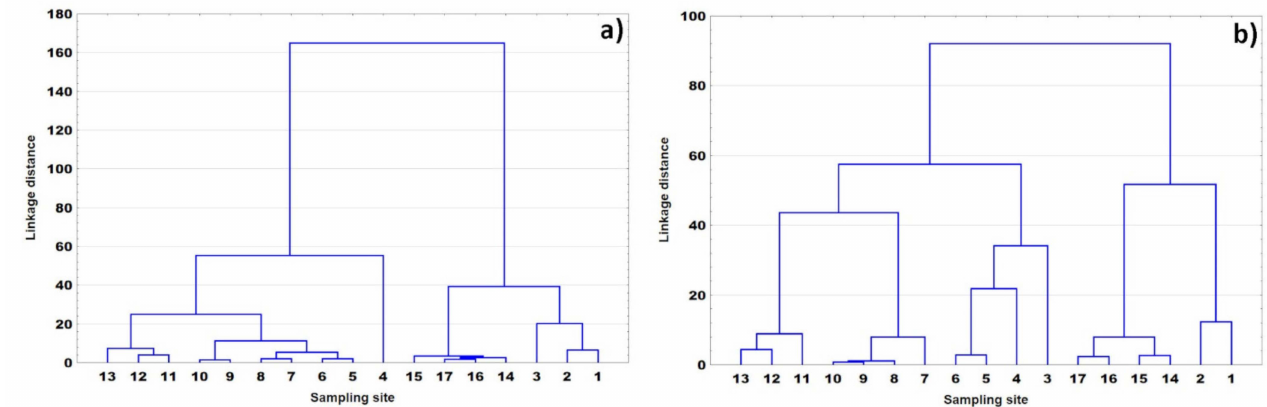
Figure 5. Dendrograms showing clustering of sampling sites in ( a ) February and ( b ) July (in